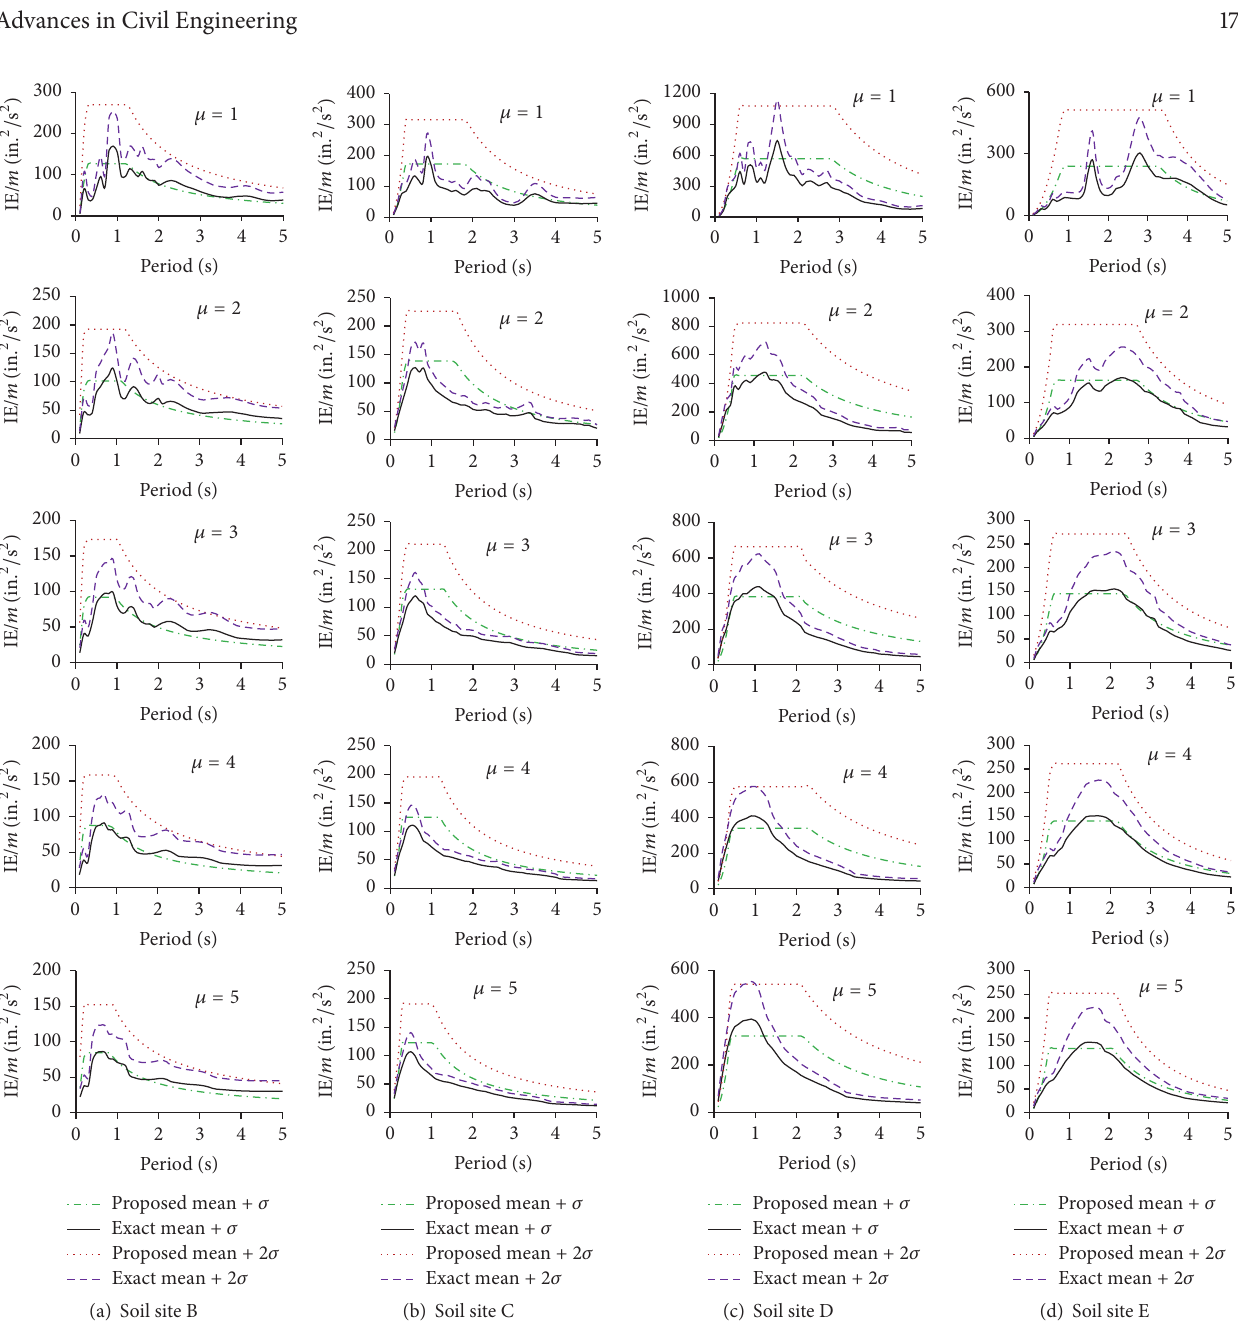
Figure 7: Comparative study of proposed input energy spectra: hysteresis model SD (𝜁 = 5 %, 𝛼 = 0.05) .